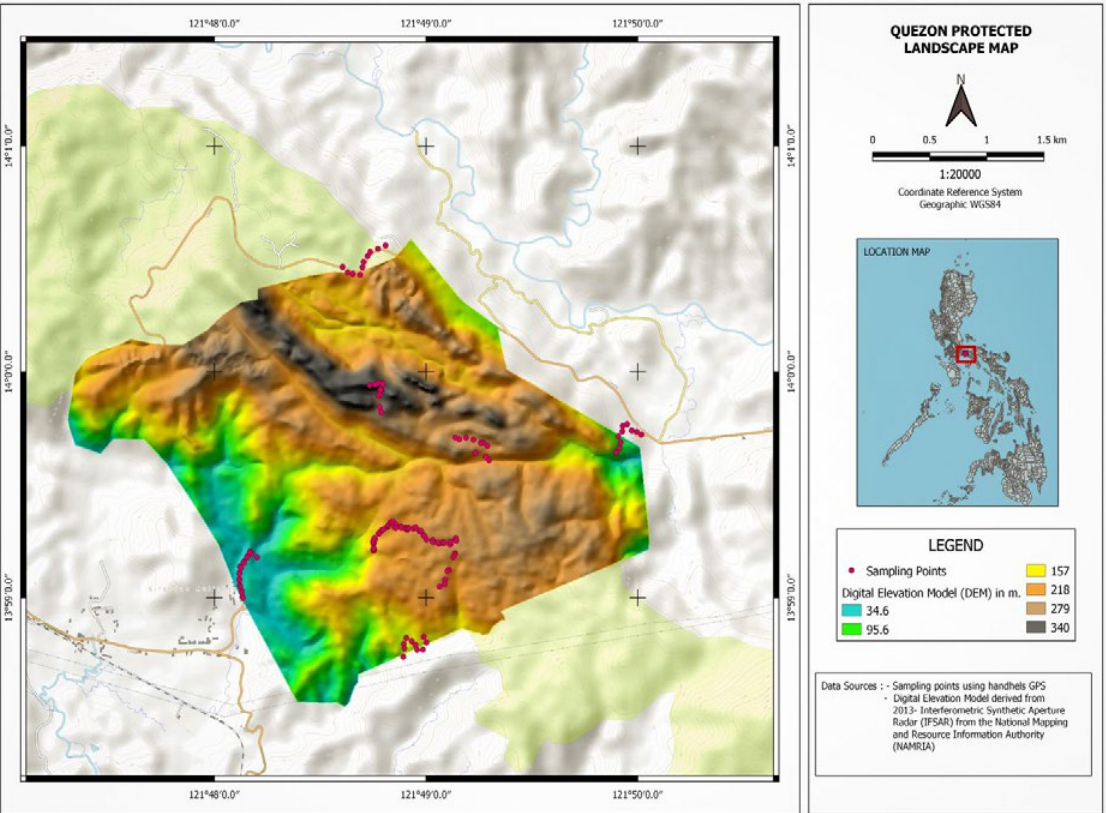
Fig. 1: The geographic location of the study area in Quezon Protected Landscape showing its boundaries and 9 established transects